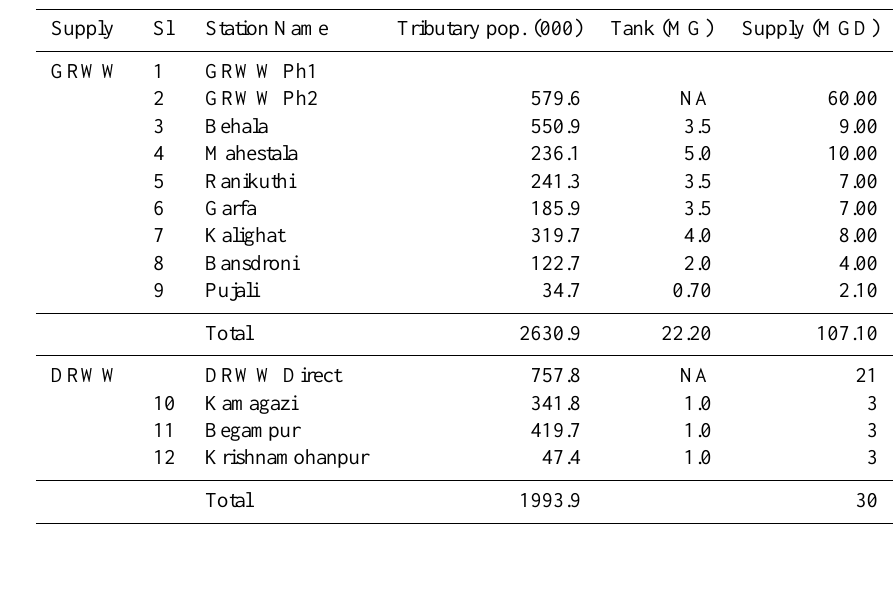
Table 2. Water pumping stations in Kolkata and southern fringes.